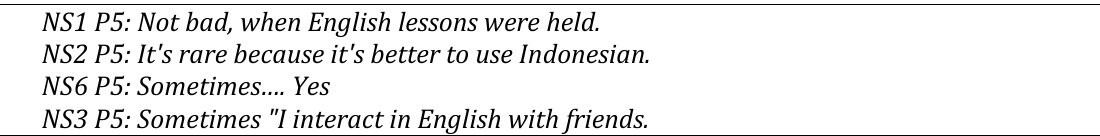
Table 8. Statement 9 questionnaire and data